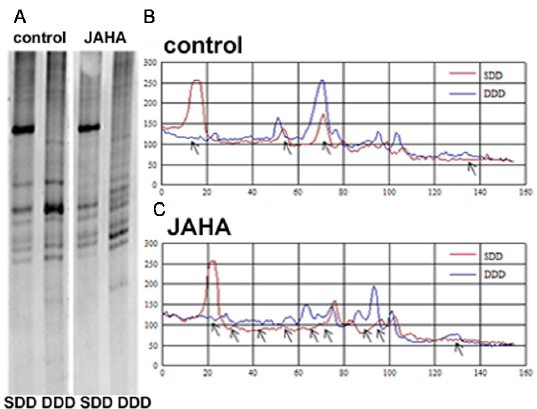
Figure 3. Analysis of genomewide DNA methylation status. Methylation ‐ sensitive restriction arbitrarily-primed (MeSAP) fingerprintings ( A ) and corresponding densitometry profiles ( B , C ) of the matched single- (SDD in (A), red profiles in (B,C)) and double-digested DNA (DDD in (A), blue profiles in (B,C)) samples from control ( B ) and JAHA-treated ( C ) MDA-MB231 cells cultured for 48 h. The